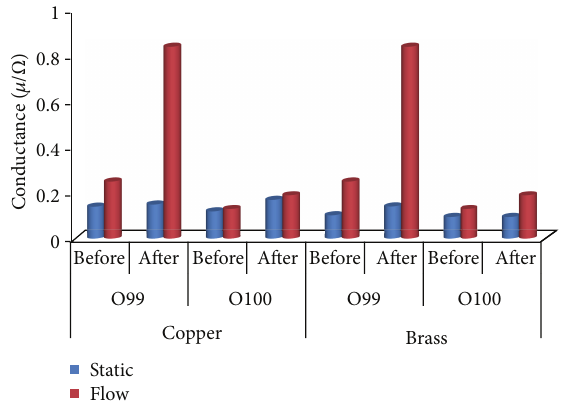
Figure 2: Conductivity of PO exposed to copper and brass at different conditions.